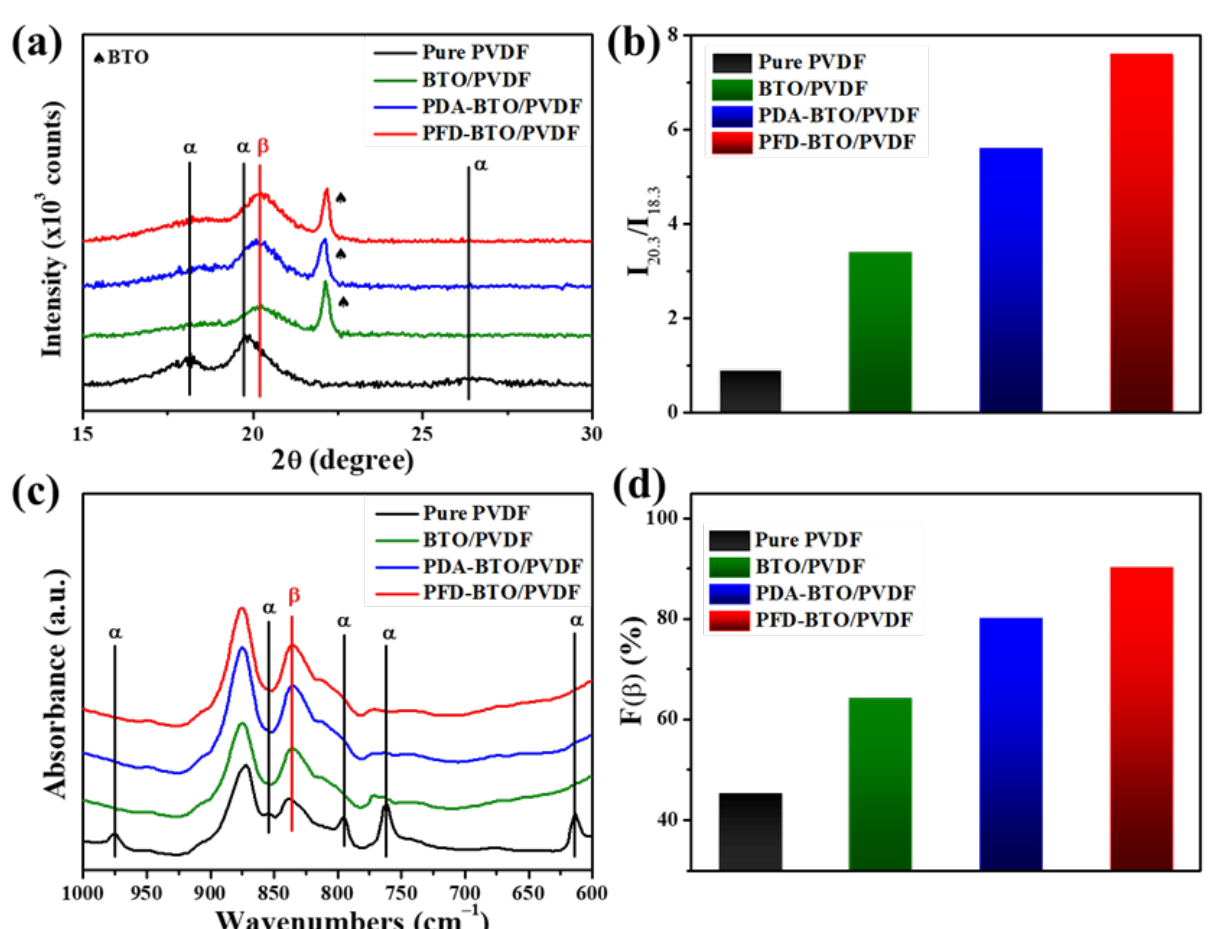
Figure 4. XRD spectra of ( a ) PVDF-based films with 8 wt% filler, ( b ) Ratio of I 20.3 and I 18.3 of the as-printed films. ( c ) FTIR spectra of PVDF-based films with 8 wt% filler and ( d ) the F(β) value of as-printed films.